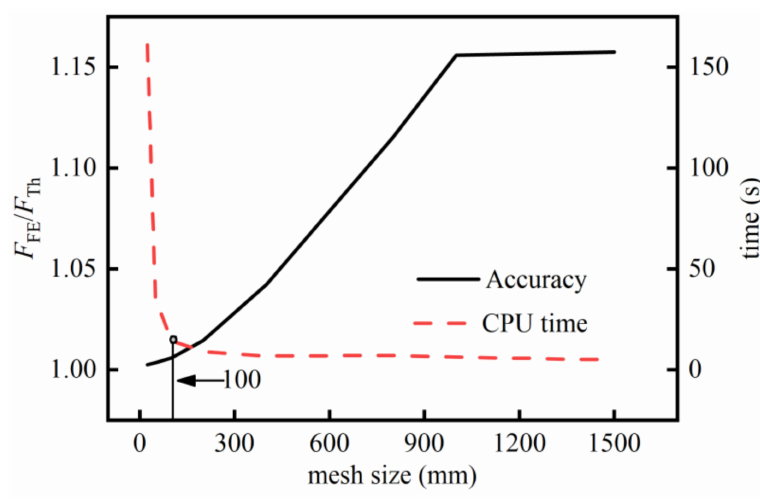
Figure 4. Curves of mesh size versus calculation accuracy and